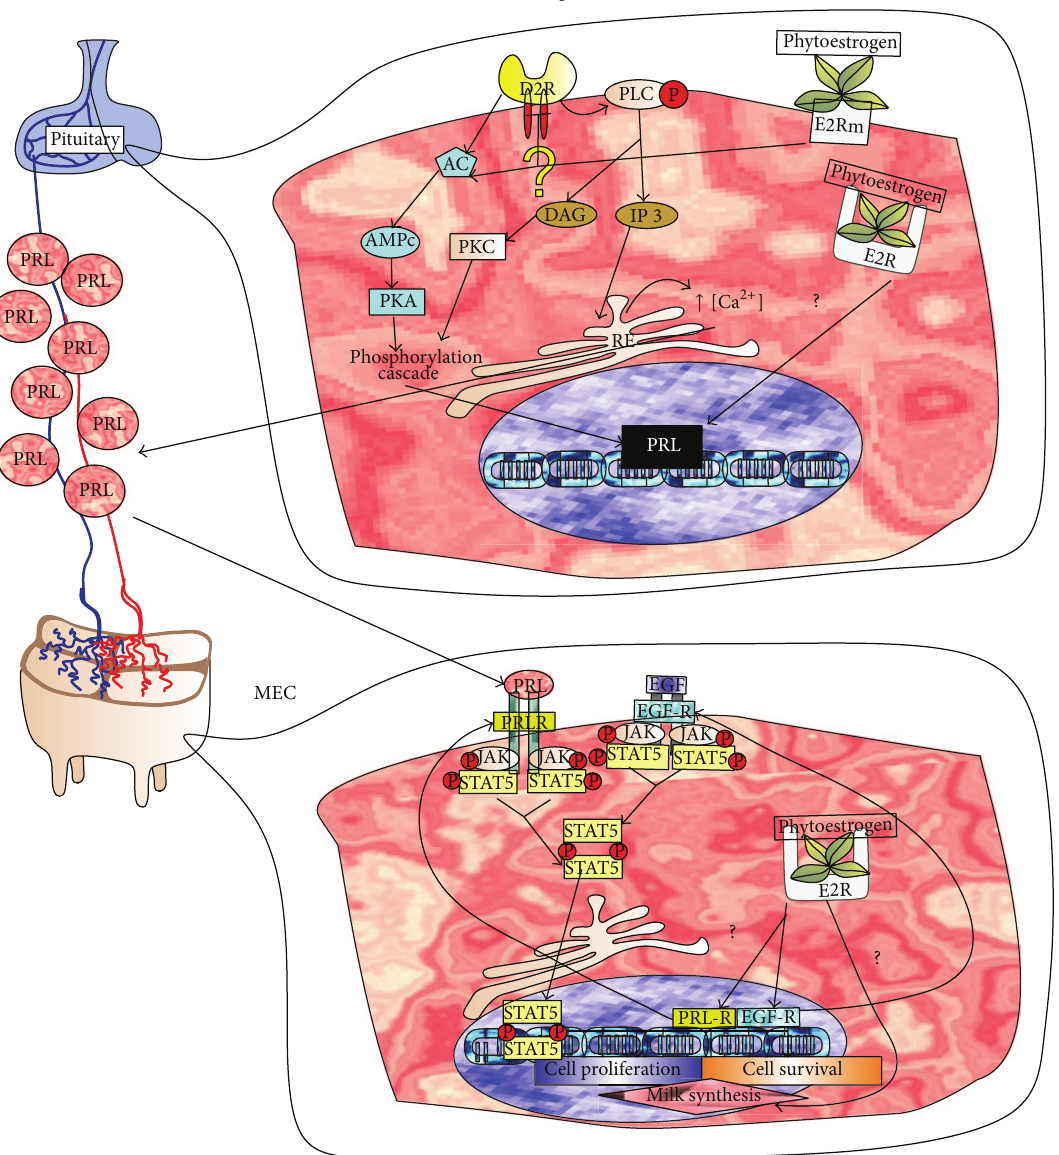
Figure 7: Proposed galactogogue mechanism of action of phytoestrogen molecules in anterior pituitary and mammary gland. The E2-like action may induce PRL expression in anterior pituitary lactotrophic cells and milk production in MEC by indeterminate pathways (?). In lactotrophic cells, upregulation of PRL gene expression and secretion occurs directly by E2R and indirectly by mE2R inducing D2R inhibition. In MEC, PRL-R and EGF-R expressions are induced and milk synthesis, cell proliferation, and survival gene expression are